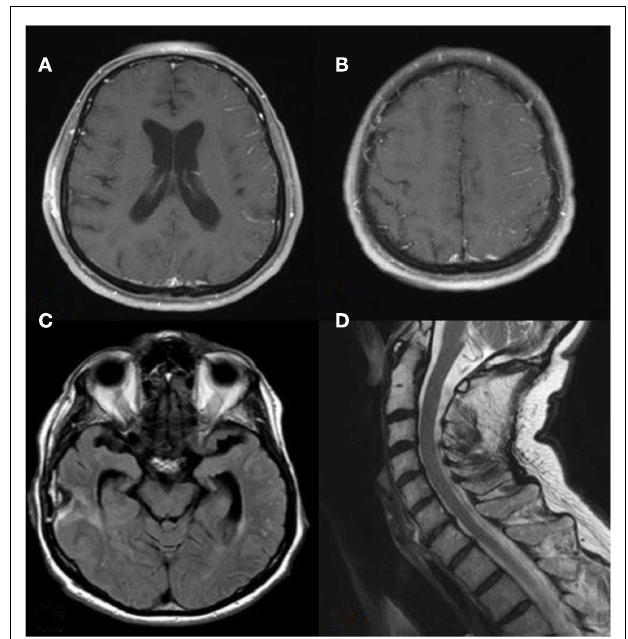
FIGURE 1 | (A,B) T1 contrast-enhanced axial MRI shows evidence of right temporal leptomeningeal enhancement. (C) T2 FLAIR shows right temporal lobe vasogenic edema. (D) Scattered subcortical white matter